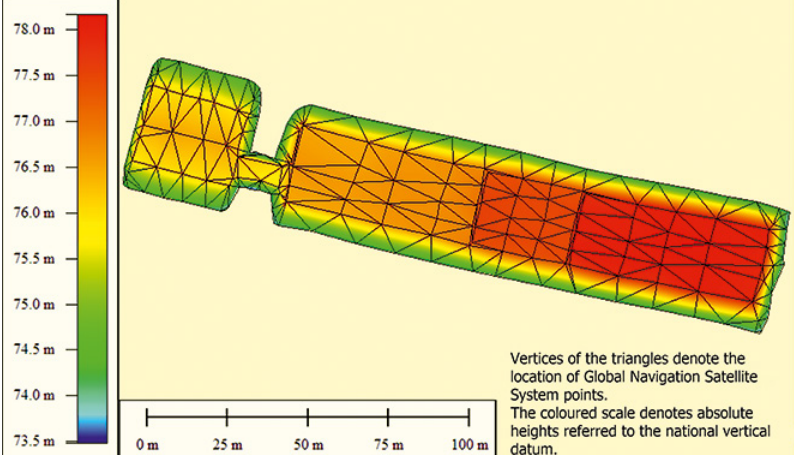
Figure 4. Digital Elevation Model of the study area derived from Global Navigation Satellite System reference